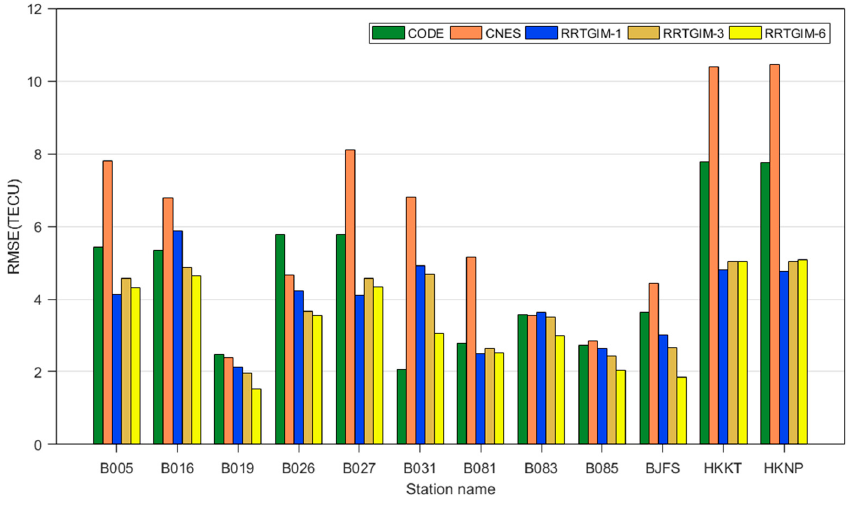
Figure 12. STEC RMSE of CODE, CNES, and RRTGIMs at UT 6:00, DOY 78, 2020.